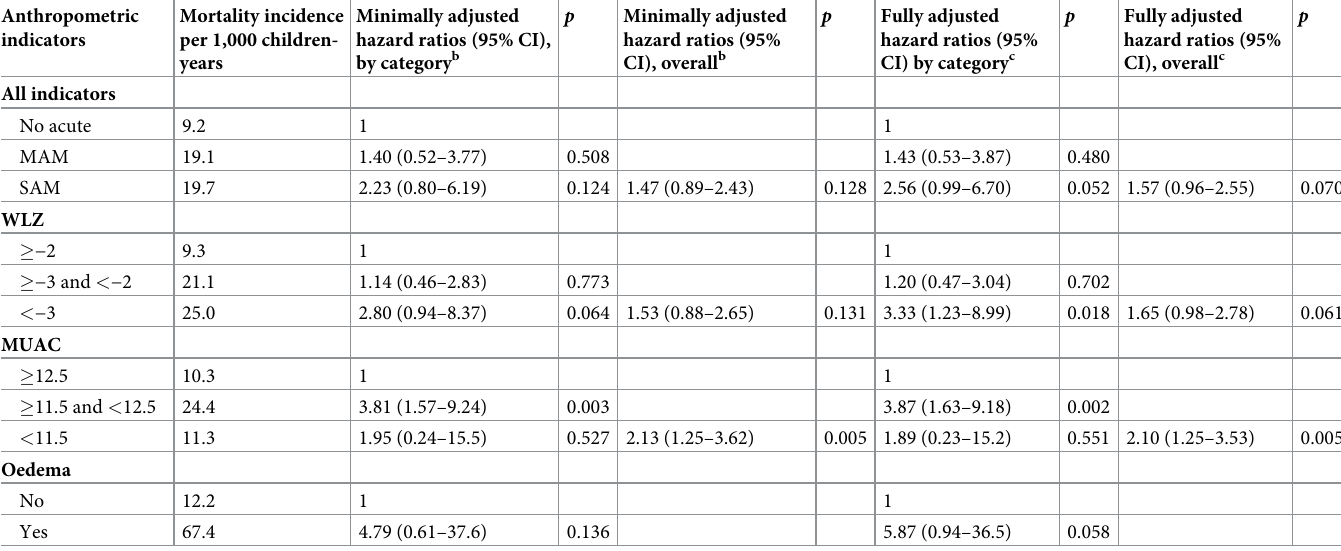
Table 2. Associations between anthropometric indicators of MAM or SAM and short-term a mortality. Anthropometric